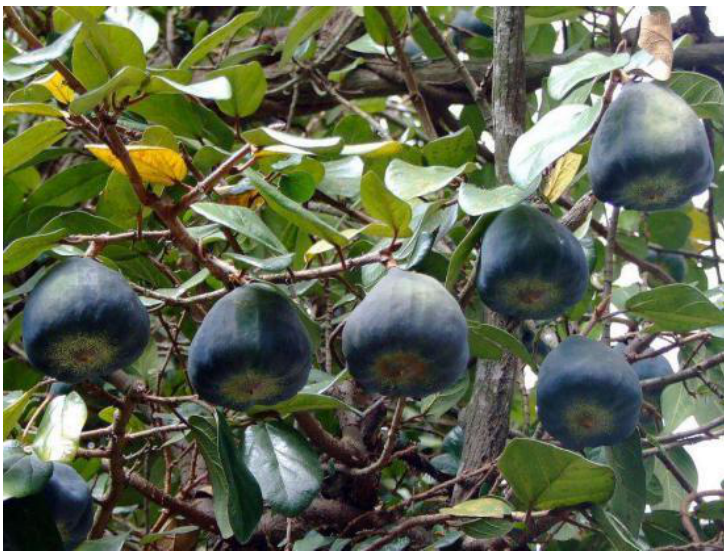
Figure 1. Stems, leaves, and fruits of Ficus pumila L. 2. Bioactive Compounds in Ficus pumila L. 2.1. Flavonoids So far, thirty-seven flavonoids (Table 1) have been identified in Ficus pumila L. The leaves and inflorescences of Ficus pumila L. have the highest flavonoid contents. In ad- dition, the contents of flavonoids in leaves are significantly higher than those in stems and seeds [26]. Table 1. Flavonoid compounds found in Ficus pumila